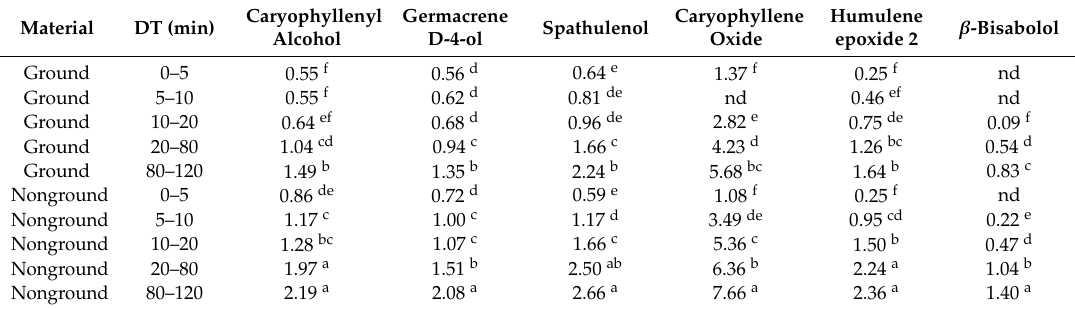
Table 4. Mean caryophyllenyl alcohol, germacrene D-4-ol, Spathulenol, caryophyllene oxide, humulene epoxide 2, and β -bisabolol obtained from the 10 combinations of Material and Distillation time